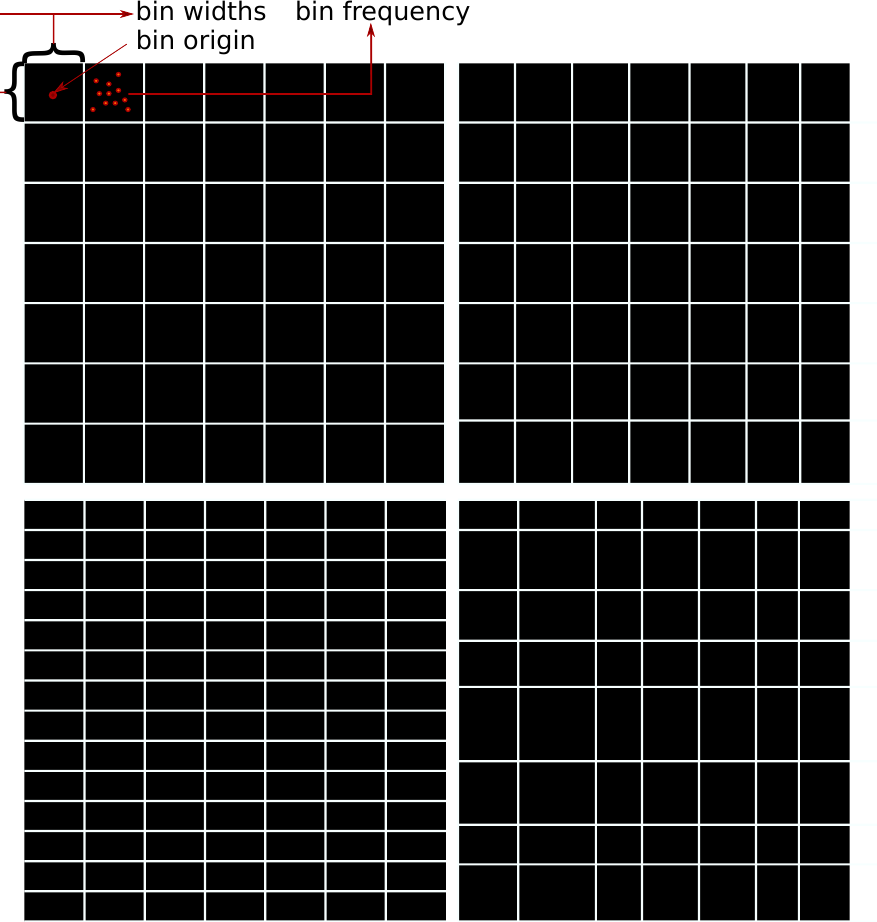
Figure 1. Examples of different grid scenarios in two dimensions. Upper left plot: each bin has an equal bin width h = { h , h } with equal sides of bin h and an equal number of partitions in each dimension v = { v , v } . Upper right plot: each bin has an equal bin width h = { h 1 , h 2 } with non equal sides of the bin h 1 (cid:54) = h 2 and an equal number of partitions in each dimension v = { v , v } . Lower left plot: each bin has an equal bin width h = { h 1 , h 2 } with non equal sides of bin h 1 (cid:54) = h 2 and a non equal number of partitions in each dimension v = { v 1 , v 2 } . Lower right plot: each bin has a different bin width h j = { h 1 j , h 2 j } with a different number of partitions in each dimension v = { v 1 , v 2 }